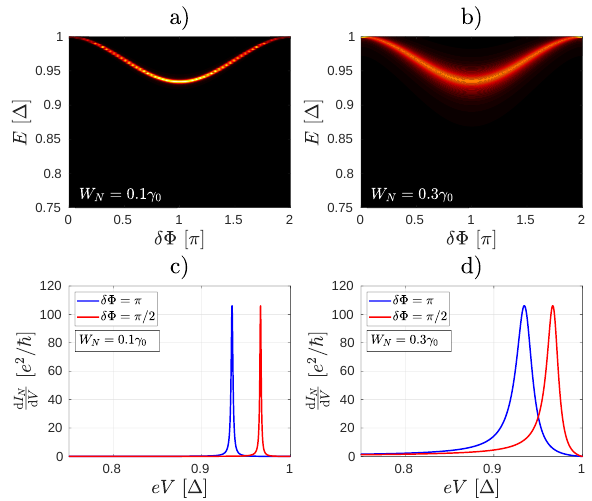
Figure 4. ( a , b ) Density of states of the molecular junction shown in Figure 2 for two different coupling W N of the normal lead to the molecule. The bright areas indicate the dispersion of the Andreev Bound State (ABS) as a function of δ Φ . The ABS energy level is broadened by increasing W N . ( c ) A resonance occurs in the differential conductance when the bias voltage eV is close to the energy E n ( δ Φ ) of the ABS in ( a ). ( d ) As the ABS is broadened, the width of the resonance broadens as well.